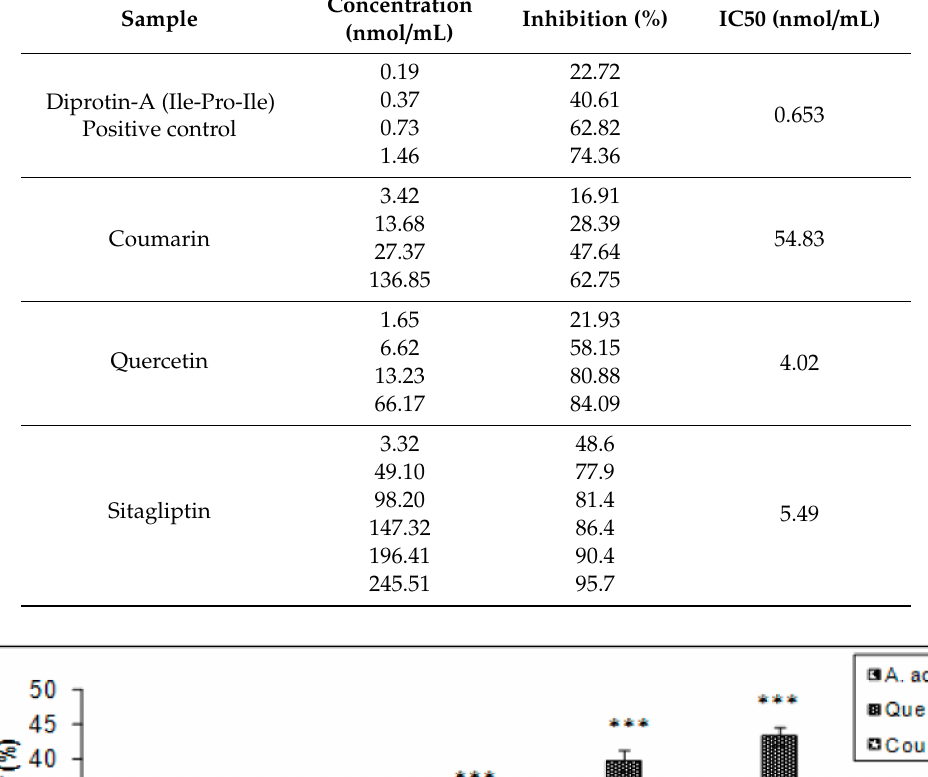
Table 2. DPP-IV enzyme Inhibition activity of Diprotin-A, Quercetin, Coumarin, and Sitagliptin.